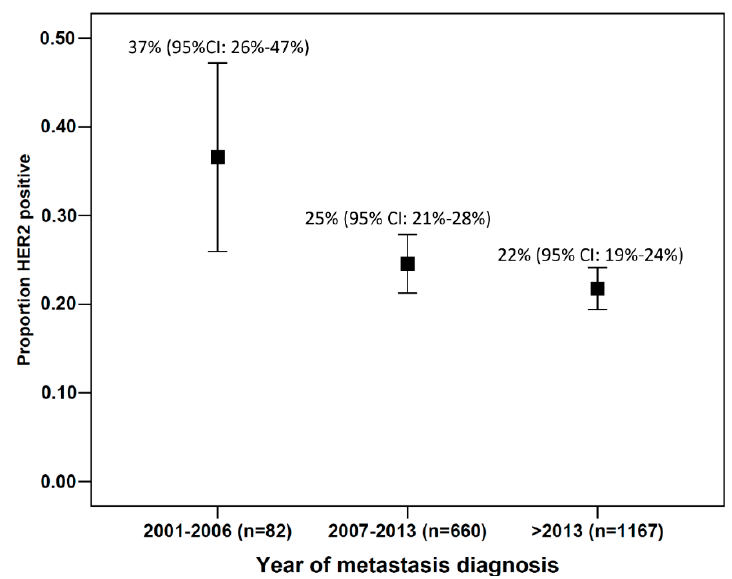
Figure 2. Proportion of human epidermal growth factor receptor 2 (HER2)-positive patients with 95% confidence intervals relative to the year in which the metastases were diagnosed.